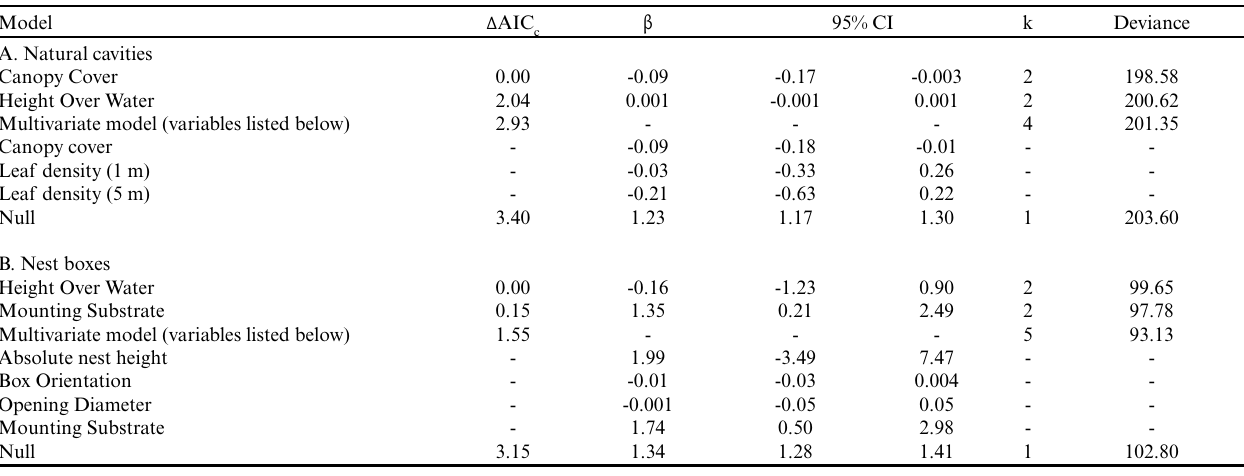
Table 7 . Top three models (and intercept-only null) describing the relationship between microhabitat variables and daily nest survival of Prothonotary Warbler ( Protonotaria citrea ) nests located in natural cavities (18 models built, AIC boxes (20 models built, AIC of top model = 101.65) at White River National Wildlife Refuge, Arkansas, USA in c